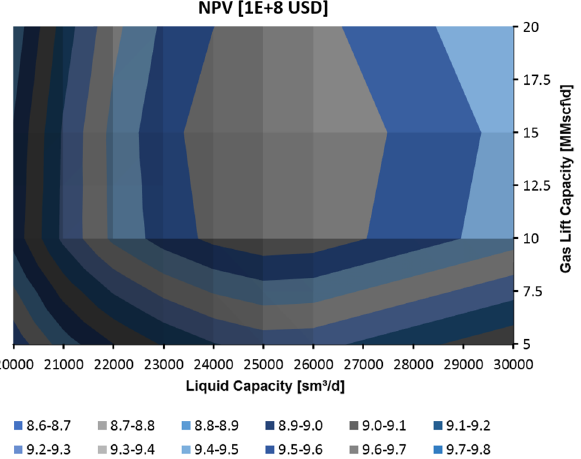
Fig. 19 NPV as a function of liquid and gas lift capacities limited to the sweet zone of Fig. 18